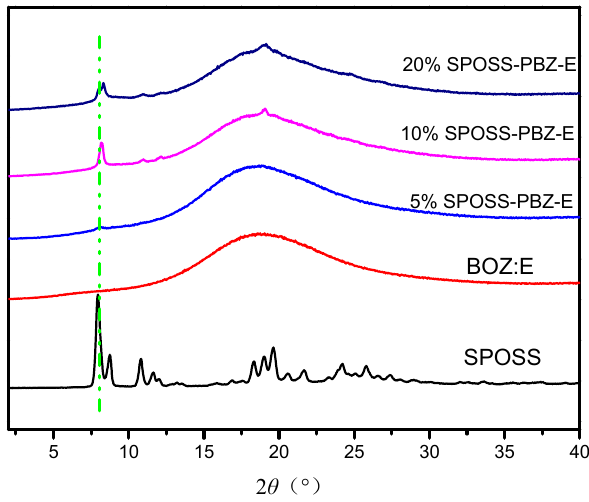
Figure 8. X-ray diffraction patterns of the SPOSS and SPOSS-PBZ-E nanocomposites.